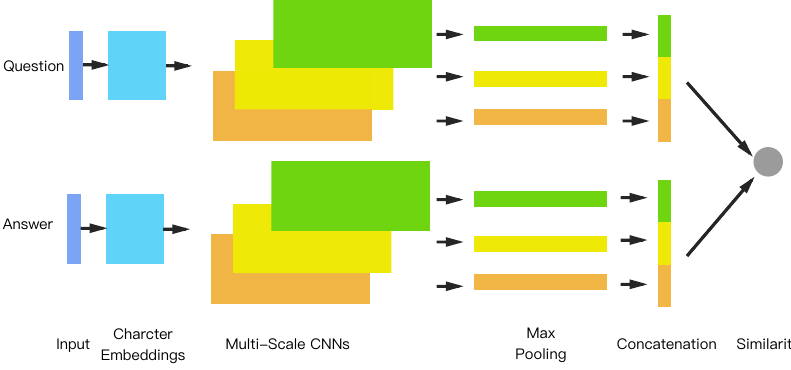
Figure 1. The framework of our model. The question and the answer are first split into characters, and they are represented by character embeddings. The embeddings are then fed into a multi-scale convolutional neural network architecture to extract local information. After that, max pooling layer reduces the representation by choosing the max value along the sequence. Finally, the vectors are concatenated to calculate the similarity of the question and the answer. It should be noted here that layers with the same color share parameters and